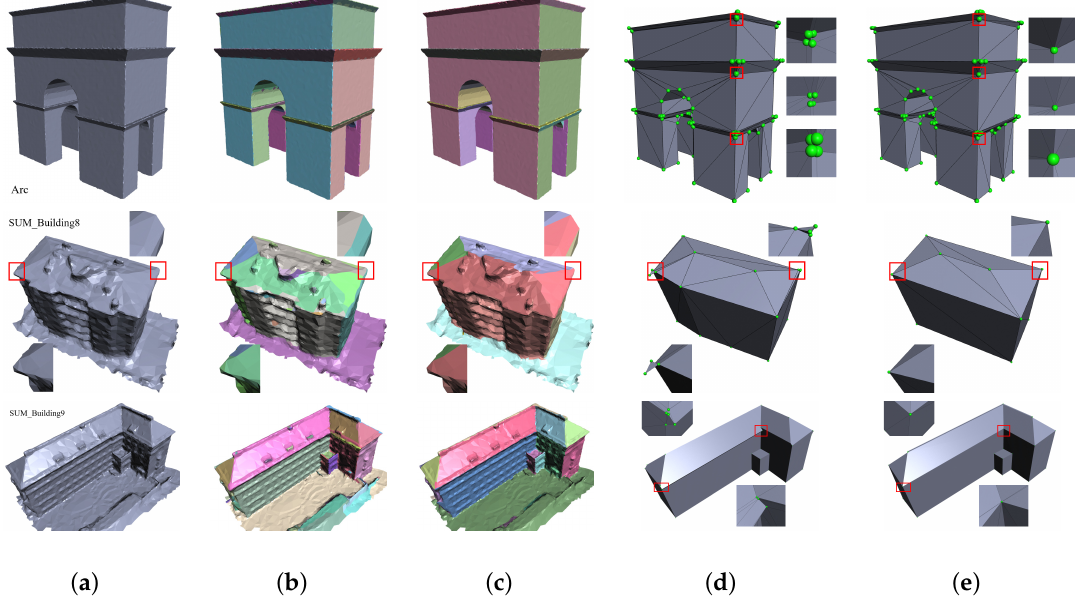
Figure 9. Comparison with SABMP [11] of segmentation and polyhedral models: ( a )